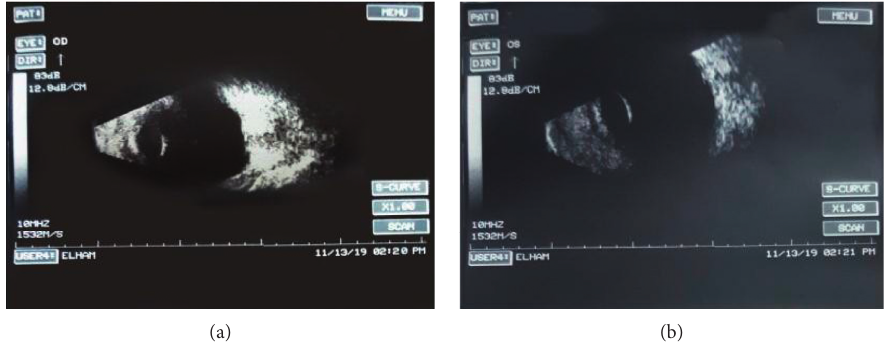
Figure 6: Ocular B-scan ultrasound of the right (a) and left (b) eyes. The ultrasound revealed an axial length of 17mm bilaterally with no other remarkable